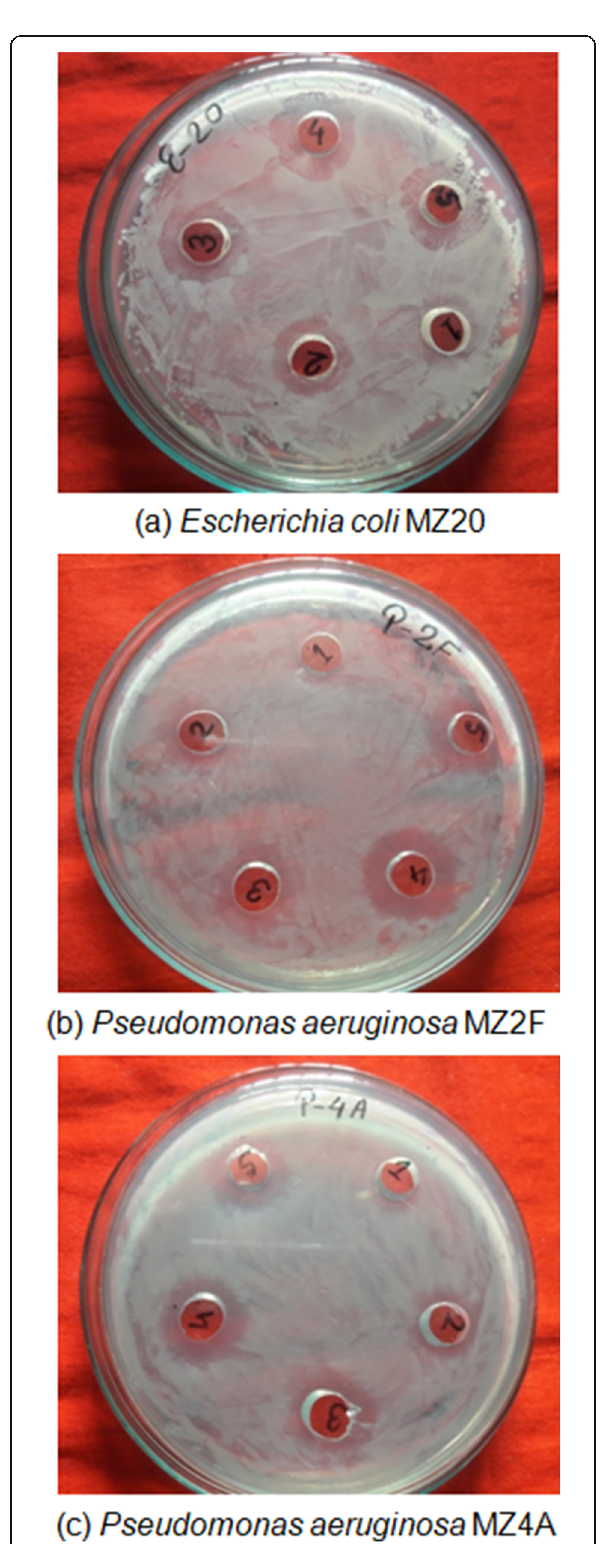
Fig. 5 Antibacterial activities of different concentrations of silk sericin-silver nanoparticles on multidrug-resistant Escerichia coli and Pseudomonas